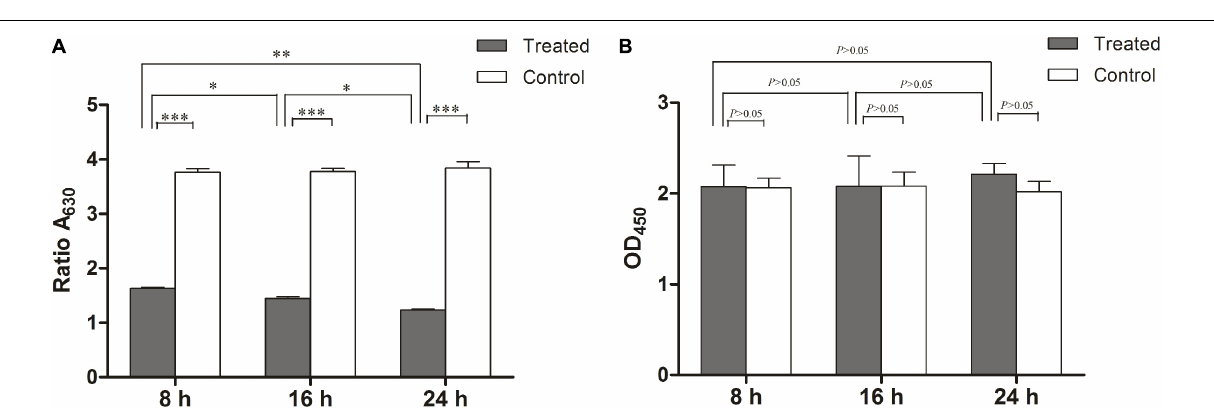
FIGURE 4 | Anti-biofilm activity of linalool against 72 h preformed biofilm of L. monocytogenes . (A) Effect of linalool on the growth and development of biofilm in control, 8, 16, and 24 h treatment groups, as determined by the CV assay. (B) Effect of linalool on the metabolic activity of biofilm in control, 8, 16, and 24 h treatment groups, as determined by the XTT assay. Bars represented the mean values (Mean ± SD; n = 3). “ ∗ ” pointed to significantly enrichment. P < 0.001 were labeled as “ ∗∗∗ ”, P < 0.01 were labeled as “ ∗∗ ”, and P < 0.05 were labeled as “ ∗